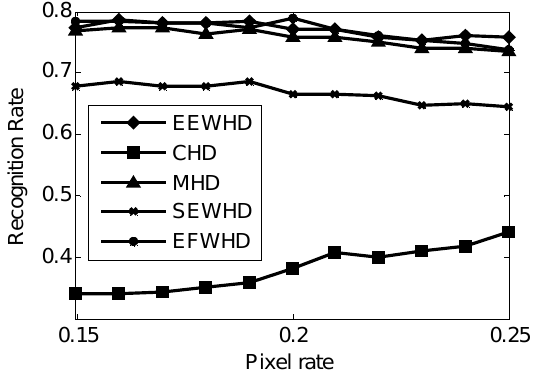
Fig. 8 Comparison of average recognition rates using different pixel ratio and different training